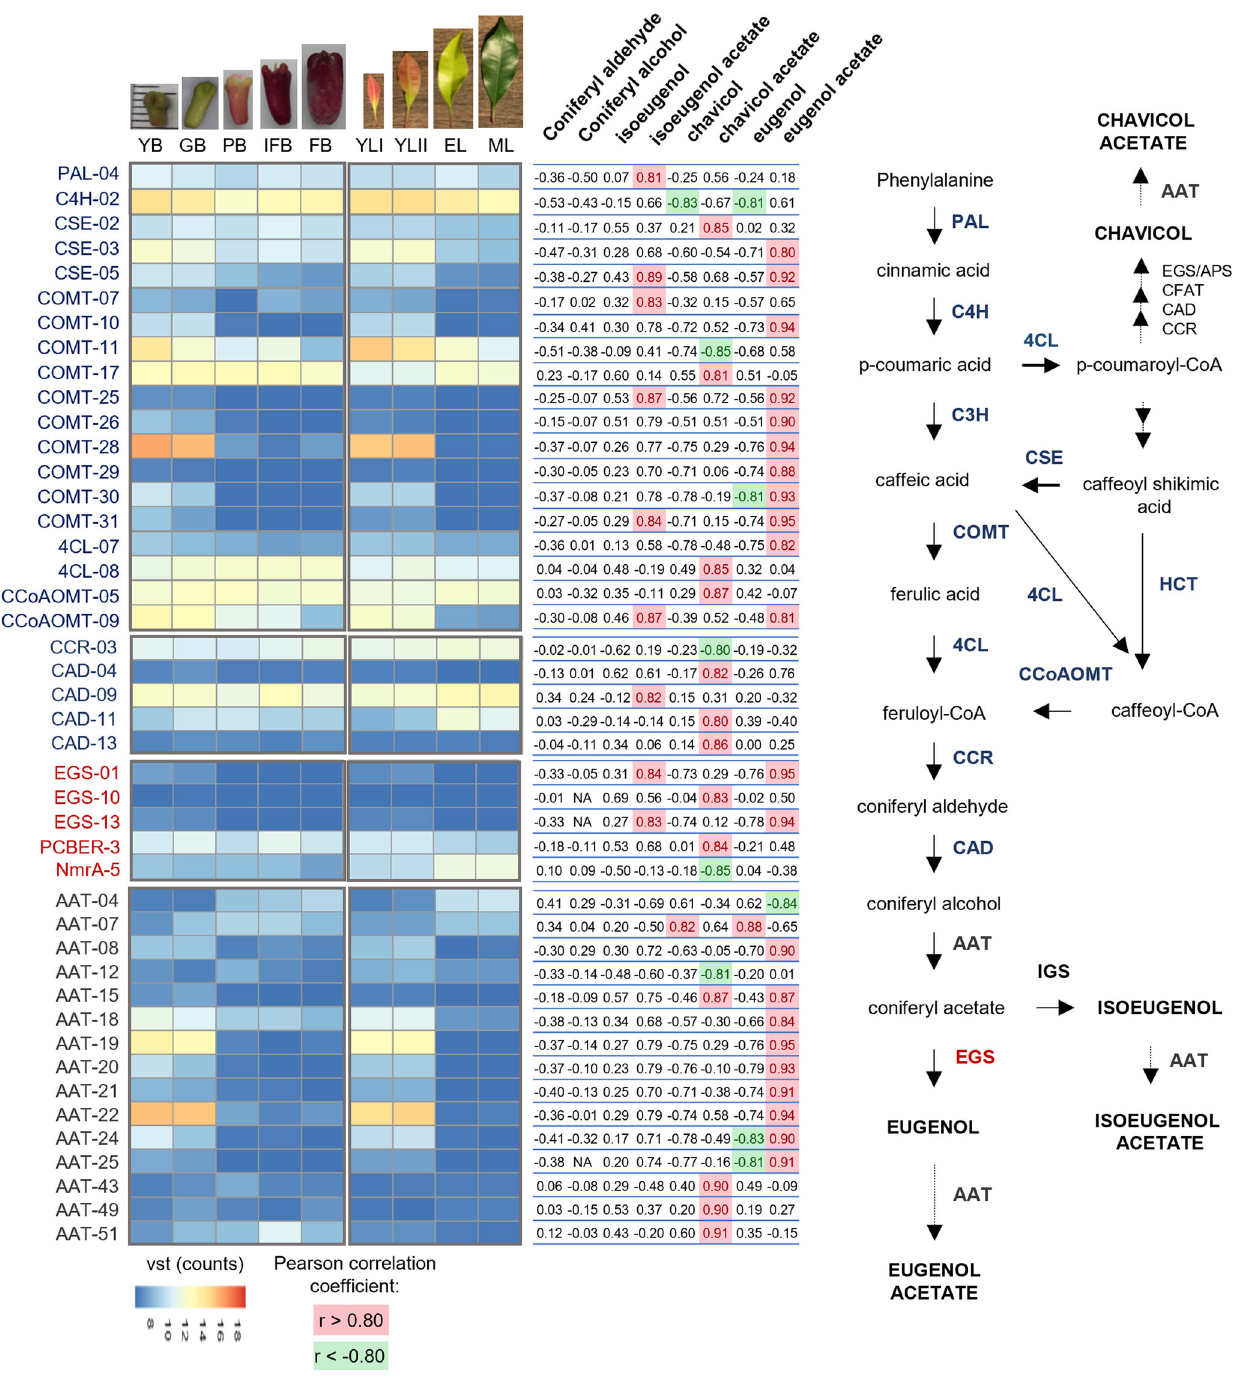
Fig. 6 List of genes possibly involved in the biosynthesis of eugenol and eugenol acetate in leaves and buds at different growth phases according to the combined transcriptomic and metabolomic data. Heatmaps indicate the expression pro fi les of genes correlated with the concentrations of the phenylpropenes eugenol and chavicol, their respective esters, isoeugenol acetate, and the precursor coniferyl alcohol (Pearson correlation coef fi cient r >0.8 to r < − 0.8, n = 3). Young buds (YB), green buds (GB), pink buds (PB), buds in the initial fruiting stage (IFB), buds in fruiting stage (FB), young leaves (YLI), expanded young leaves (YLII), expanded pale green leaves (EL) and mature leaves (ML). PAL phenylalanine ammonia-lyase, C4H cinnamate 4-hydroxylase, C3H 4-coumarate 3-hydroxylase, COMT caffeate/5-hydroxyferulate 3- O -methyltransferase, 4CL 4-hydroxycinnamate:CoA ligase, HCT 4-hydroxycinnamoyl CoA:shikimate/quinate hydroxycinnamoyltransferase, CSE caffeoyl shikimate esterase, CCoAOMT caffeoyl CoA 3-O-methyltransferase, CCR cinnamoyl CoA reductase, CAD cinnamyl alcohol dehydrogenase, CFAT coniferyl alcohol acyltransferase, EGS eugenol synthase, APS allyl-phenylpropene synthase, IGS isoeugenol synthase, AAT alcohol acyltransferase, VST variance stabilizing transformation.